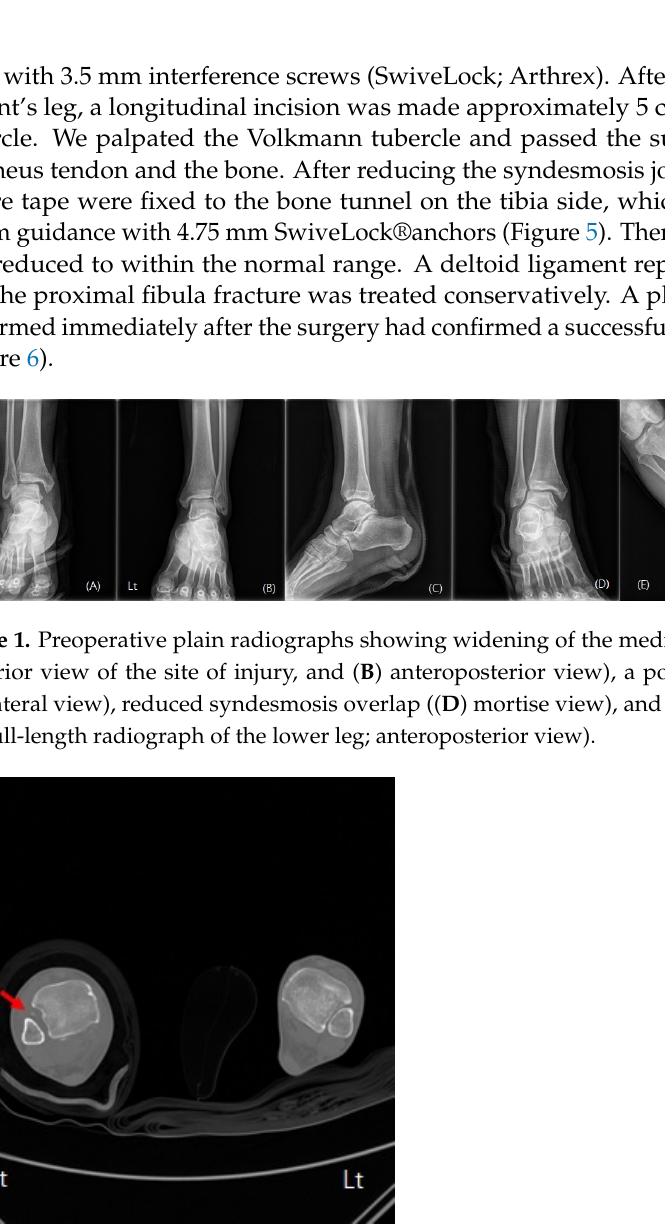
Figure 4. Intraoperative arthroscopic fi ndings of syndesmotic injury with widening of the gap be- tween the fi bula and tibia ( A ), and posterior inferior tibio fi bular ligament rupture at the point of tibial insertion ( B ). Figure 5. ( A ) Con fi rmation of anterior inferior tibio fi bular ligament rupture. ( B ) Check of the distal tibial footprints and a 3.4 mm bone tunnel was created. ( C ) In the syndesmosis ligament in the distal fi bula using a 2.7 mm drill. ( C ) A 2.7 mm drilling was performed on the footprints of the syndesmo- sis ligament in the distal fi bula from front to back to create a bone tunnel. ( D ) Suture tape was passed through the bone tunnel and fi xed with interference screws. ( E ) Under C-arm guidance, a bone